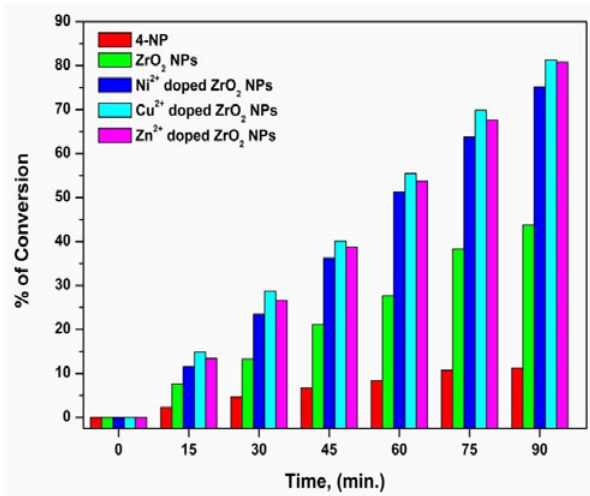
Fig. 9. The catalytic conversion of undoped and doped ZrO Fig. 9 The catalytic conversion of undoped and doped ZrO 2 NPs catalyst for the reduction of 4- NP with NaBH 4 .